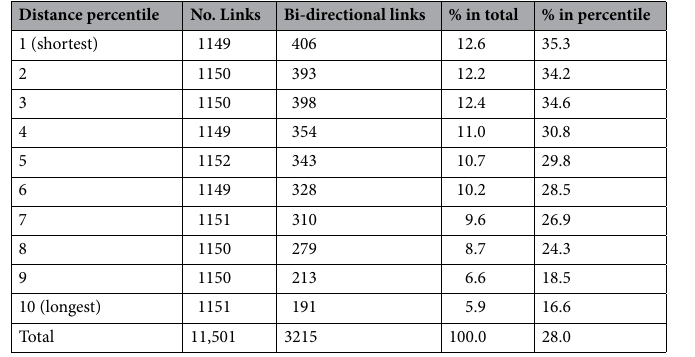
Table 3. Distribution of bidirectional links by distance